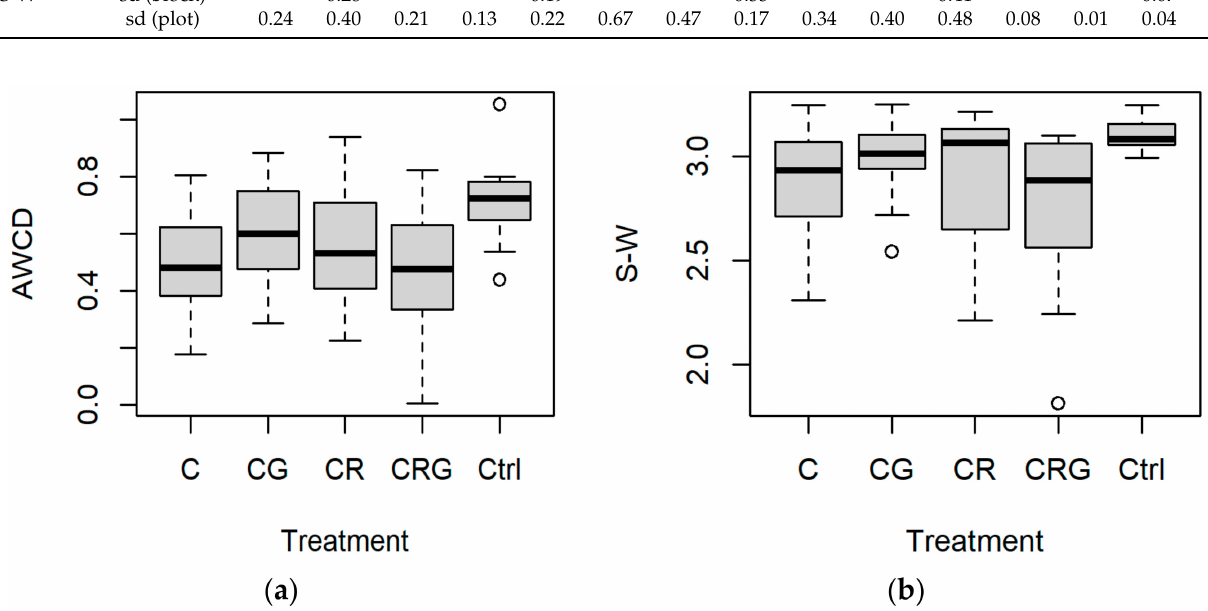
Figure 2. Boxplots of the ( a ) average well color development (AWCD) and ( b ) Shannon–Wiener diversity indices of metabolized substrates after the 384 h incubation. The boxplots show the medians and quantiles (0.25 and